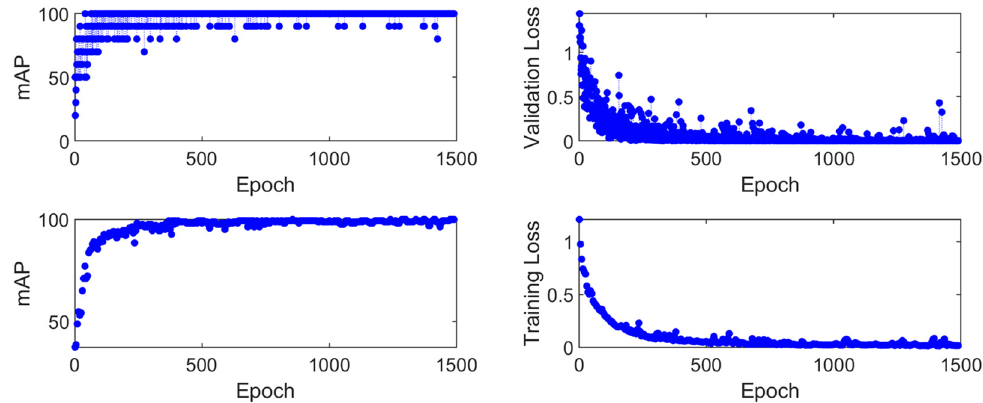
Figure 13. The training process of transfer learning.